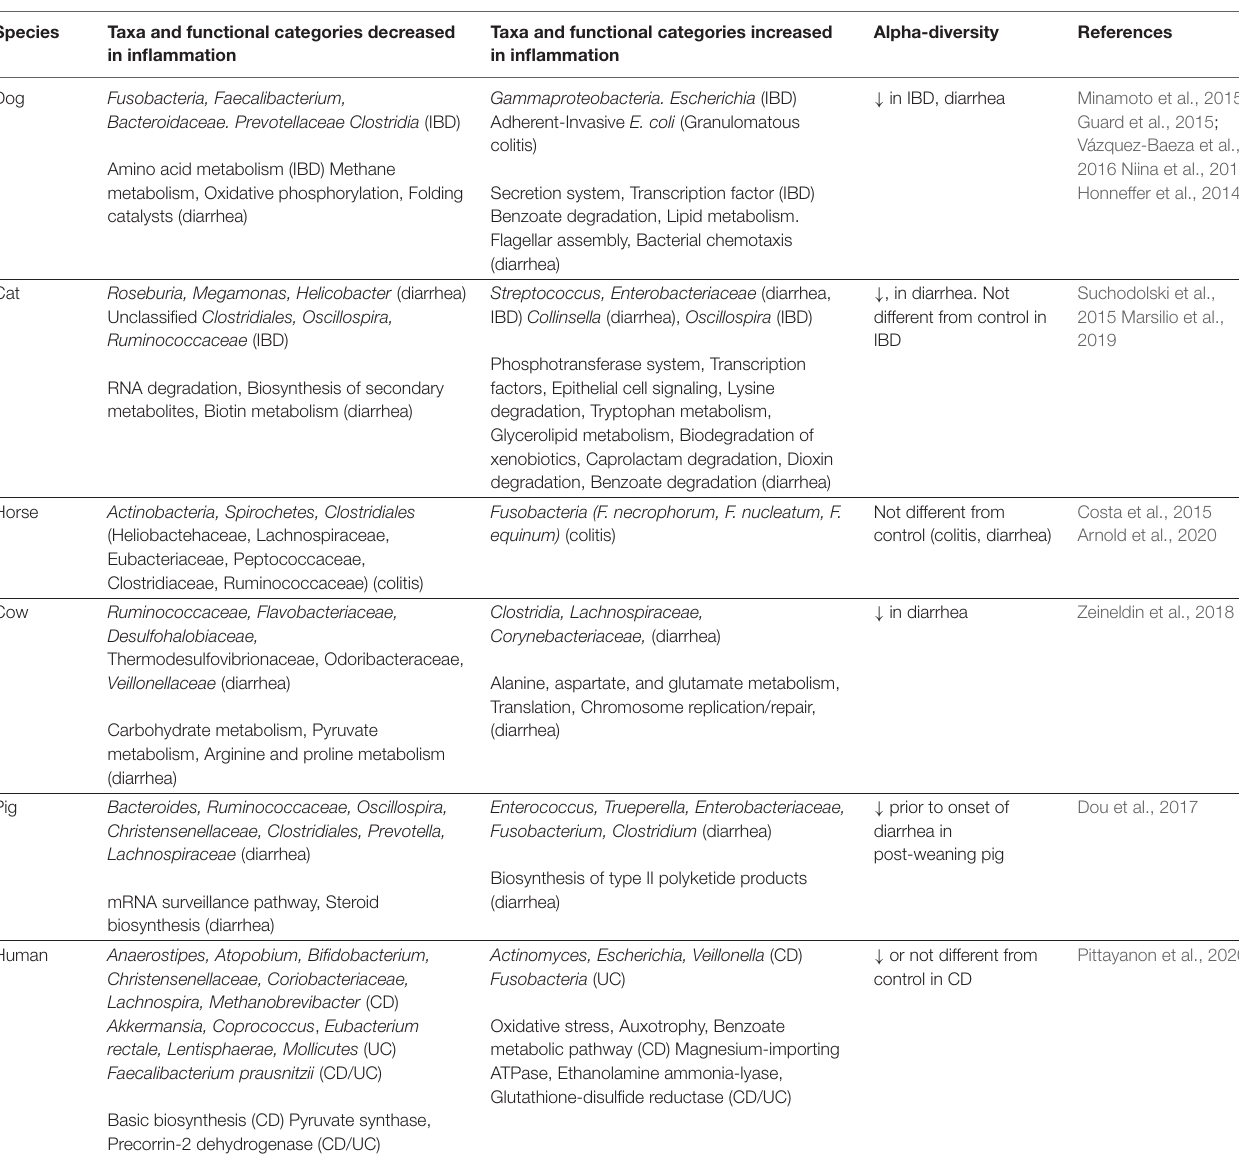
TABLE 1 | Altered microbiota composition and function in intestinal inflammation across domestic animals.